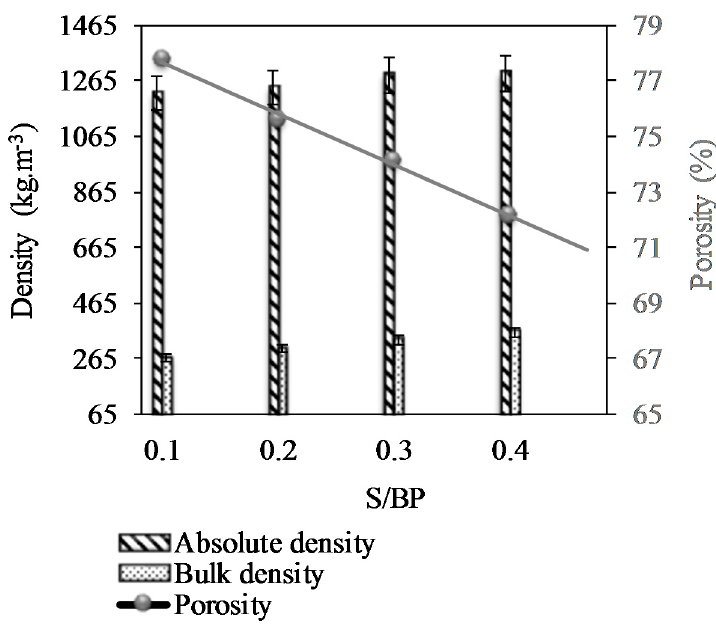
Figure 10. Density and porosity of S ‐ BP composite measured by cyclohexane method.